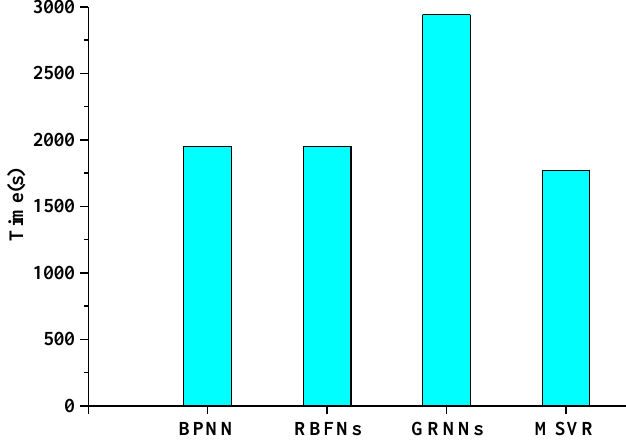
Figure 6. Time required using the four machine learning methods to retrieve LAI values over a MODIS tile in 1200 rows by 1200 columns.